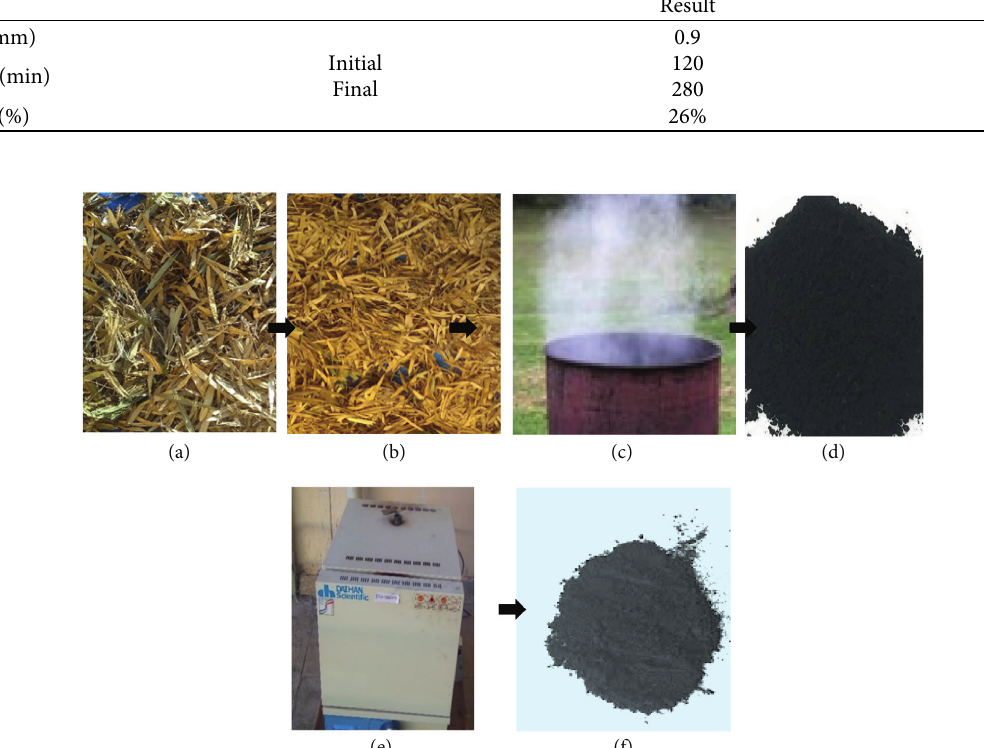
Figure 1: Bamboo leaf ash (BLA) preparation process. (a) Bamboo leaf. (b) Sun-dried bamboo leaf. (c) BL burning in the open air. (d) BLA